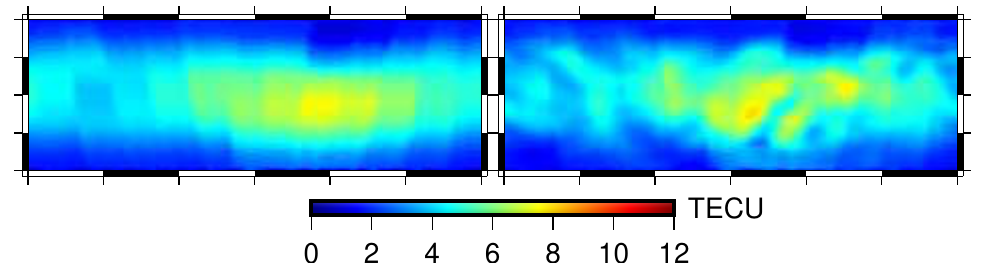
Figure 6. VTEC map of the top region at 16:00–18:00 UTC on DOY 010, 2008: ( left ) the model constructed by the method of Wu et al.’s; and ( right ) the model that was re-assimilated using podTec with the constructed model.